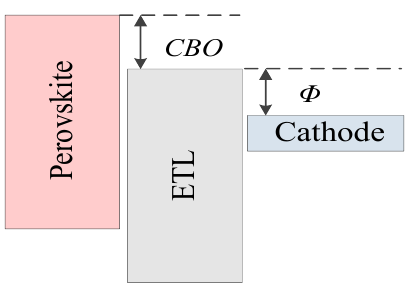
Figure 5. Schematic diagram of conduction band offset ( CBO ) and Φ .